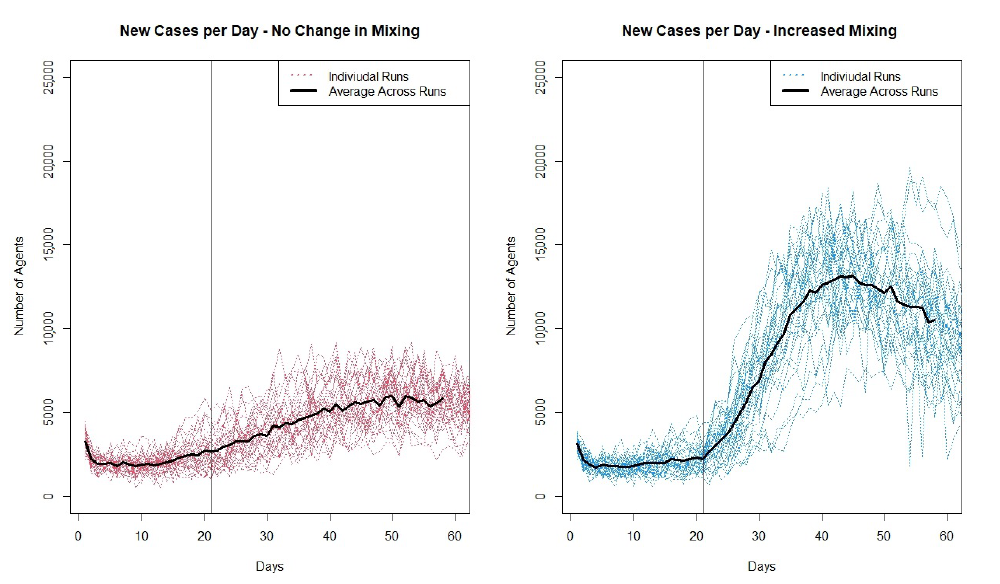
Figure 6. Plot showing the number of new infectious cases per day for the individual runs from the two